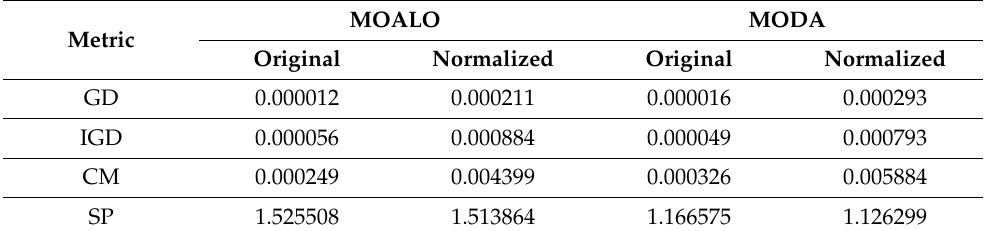
Table 4. Comparison of MOALO and MODA with NSGA-II Pareto solutions.